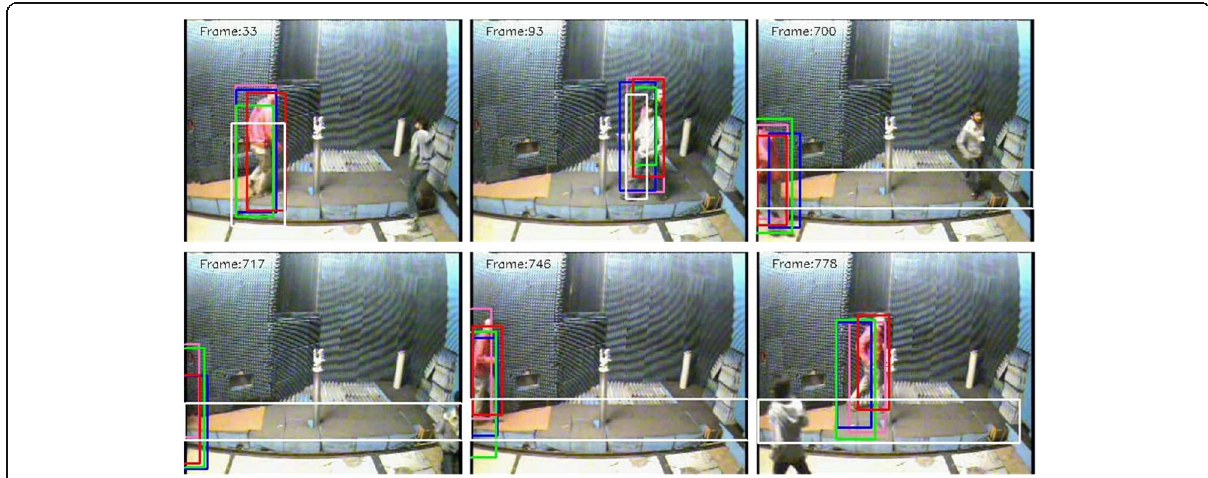
Fig. 11 The tracking results for the video “ motinas_chamber ” using CAM-Shift (white), PF (blue), VAPF(green), M-PF(pink), and the proposed tracker (red). Particle number N =